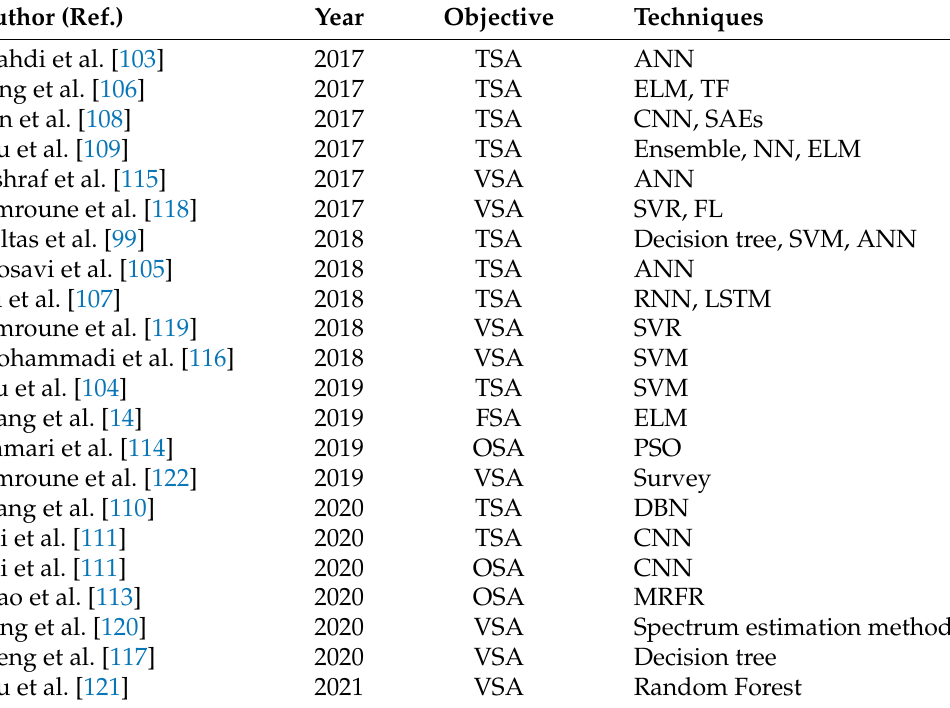
Table 2. Summary of approaches for the power system stability